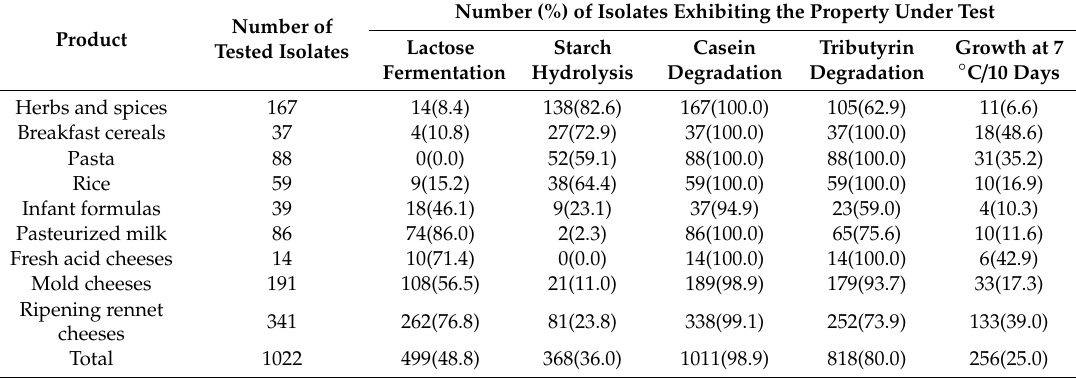
Table 2. The biochemical and physiological properties of tested Bacillus cereus isolates from various foodstu ff s. Number of Product Tested